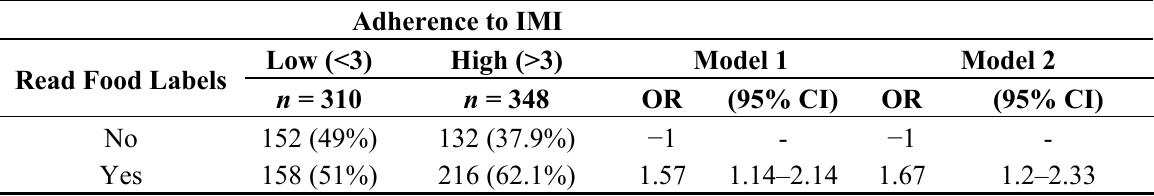
Table 6. Odds ratios of having high adherence to Italian Mediterranean index (IMI) according to food labels